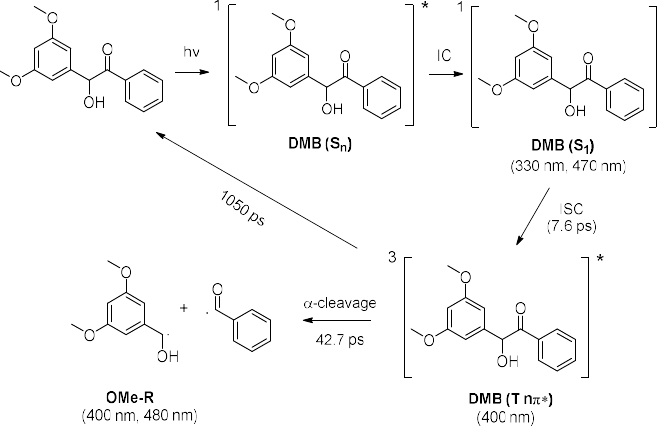
Scheme 2. Proposed reaction mechanism of the photochemical α -cleavage reaction of DMB in MeCN. Absorbance for the transient species detected from fs-TA and/or ns-TA spectra are given.